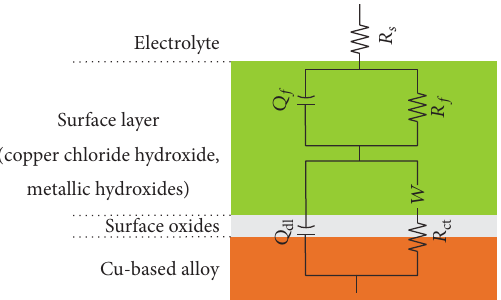
Figure 8: Equivalent circuit for Cu-based coins evaluated in artificial sweat at 37 ∘